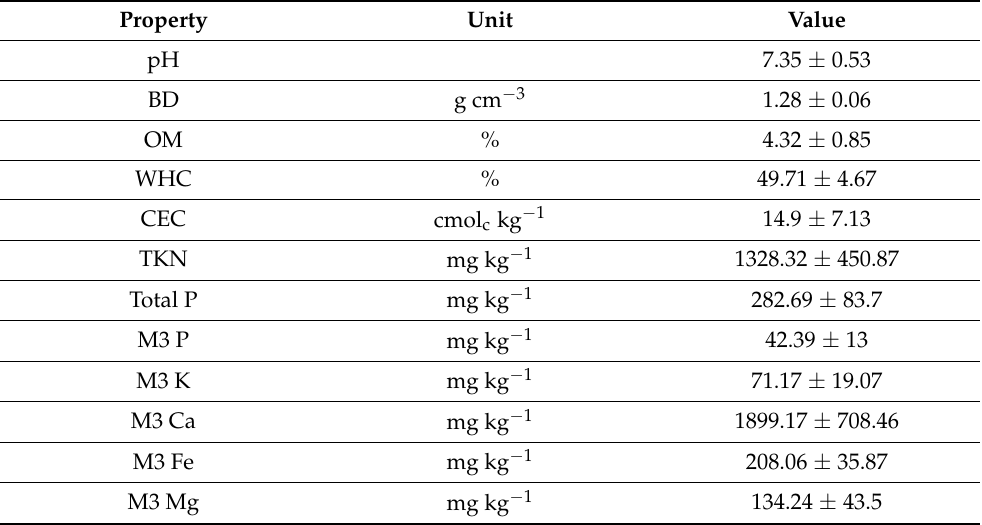
Table 1. Basic physiochemical properties of Margate mineral soils (0–30 cm depth) in the experiment site ( n = 10) (mean and standard